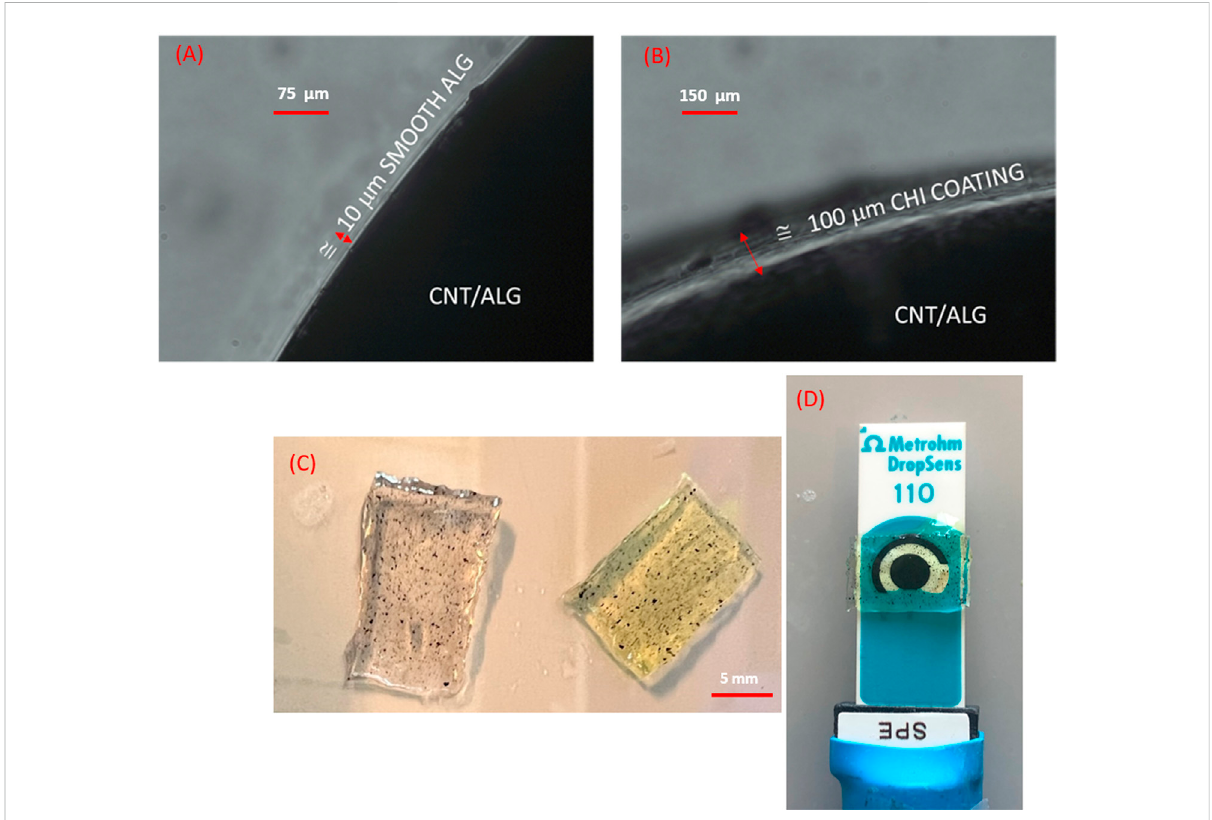
FIGURE 2 Surface coating of nanocomposites (A) Alginate control fi lm containing SWCNT, (B) Chitosan coated alginate fi lm containing SWCNT with a 100 μ m added thickness captured at ×40 magni fi cation; (C) Nanocomposite fi lm prior (translucent) and post (translucent green) electrochemical processing; (D) Screen-printed sensor with carbon working, silver reference, carbon counter electrodes and nanocomposite fi lm used for H 2 O